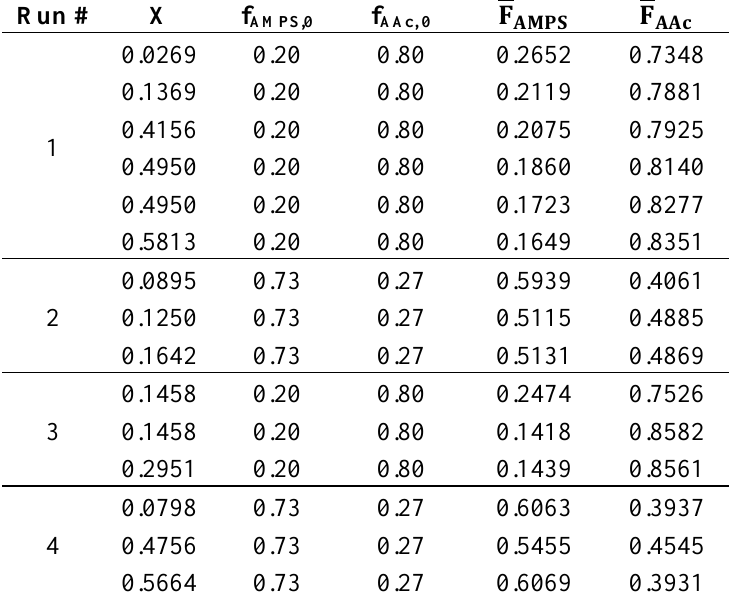
Table A4. Experimental data for AMPS/AAc copolymerization; Error-in-Variables-Model design. Run